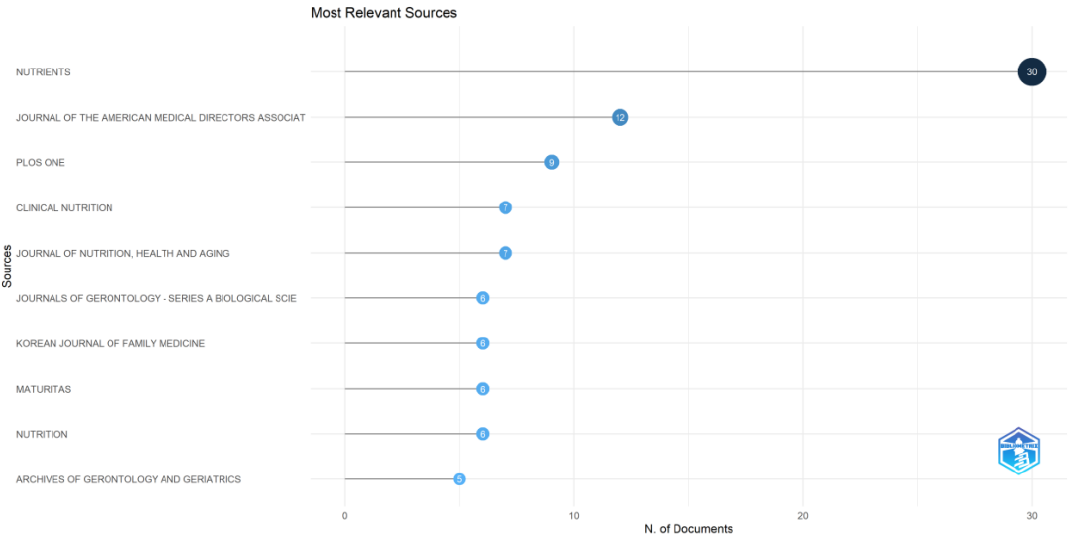
Figure 6. Top 10 journals publishing nutrition studies on sarcopenia.